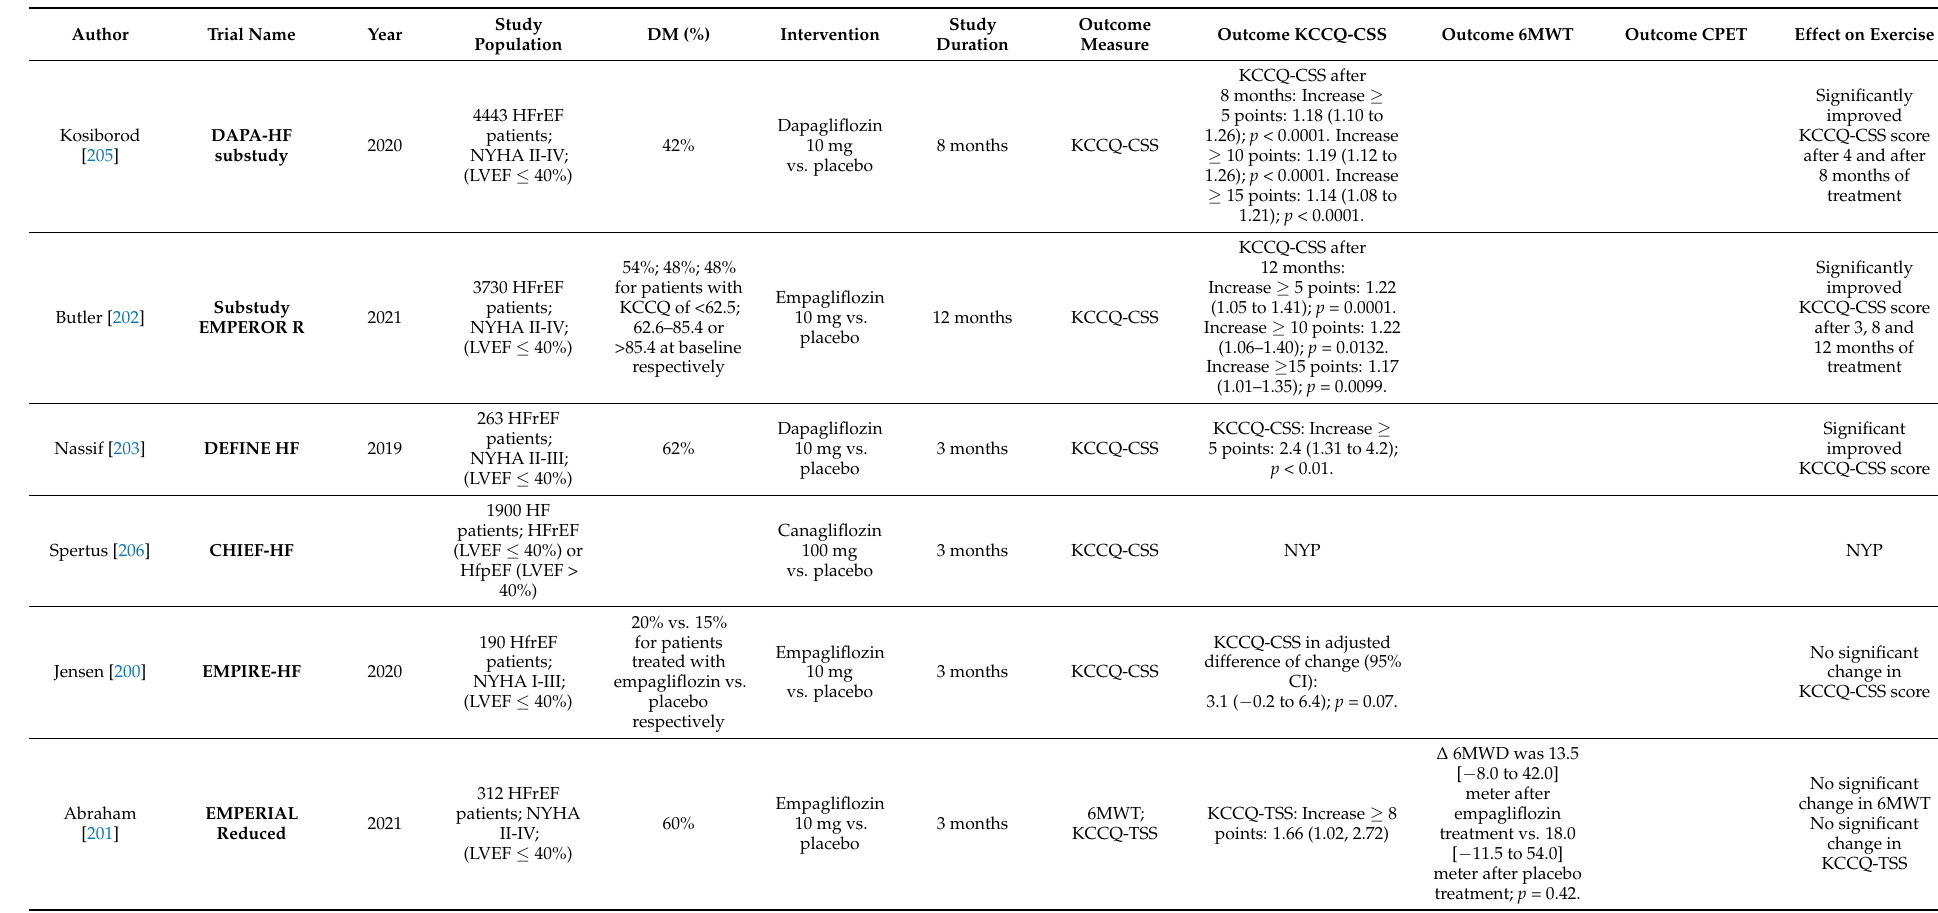
Table 2. Overview of clinical studies on the effect of SGLT2 inhibitors on exercise performance in